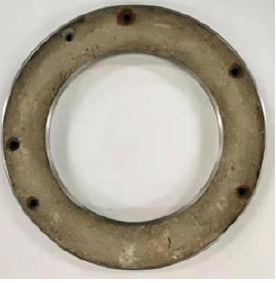
Figure 6. Interface sample after grouting. Table 2. Polymer technical indicators.